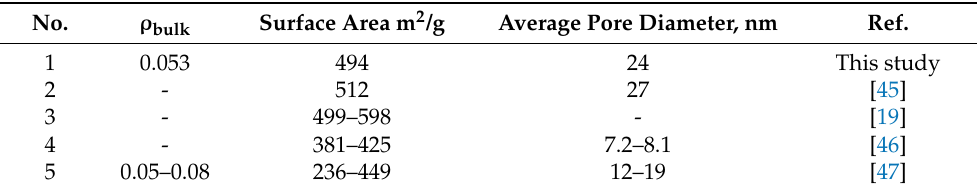
Table 5. Alginate aerogel properties in this study and in other research.